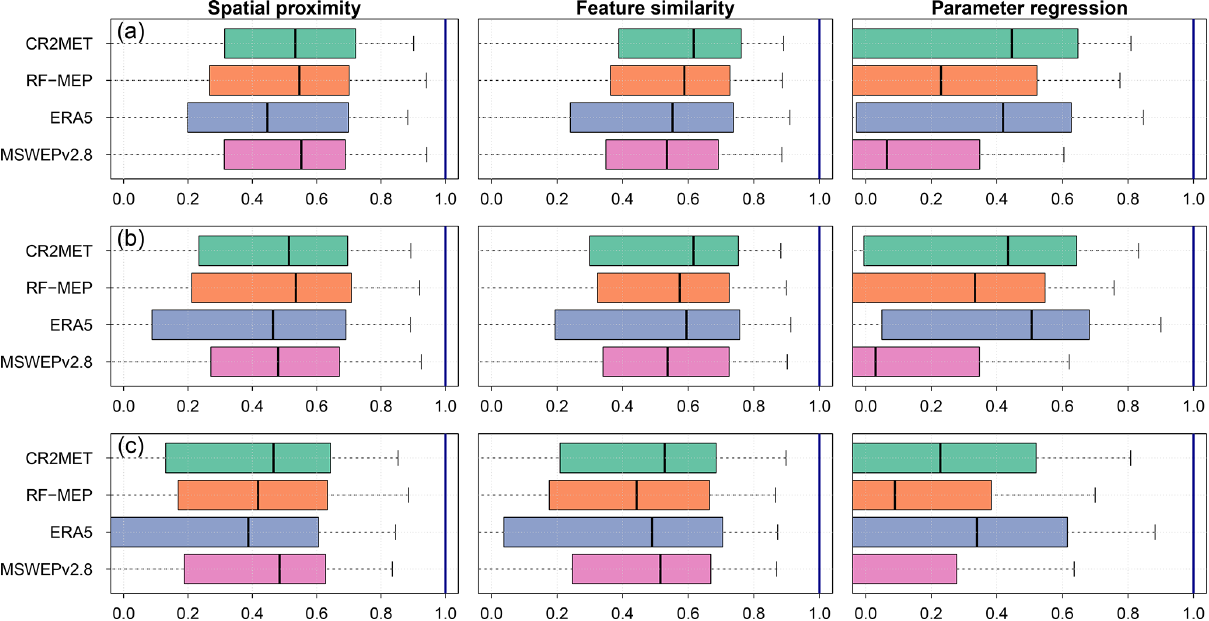
Figure 6. Leave-one-out cross-validation results for the three regionalisation methods applied with different P products during the (a) cali- bration (2000–2014), (b) Verification 1 (1990–1999), and (c) Verification 2 (2015–2018) periods.